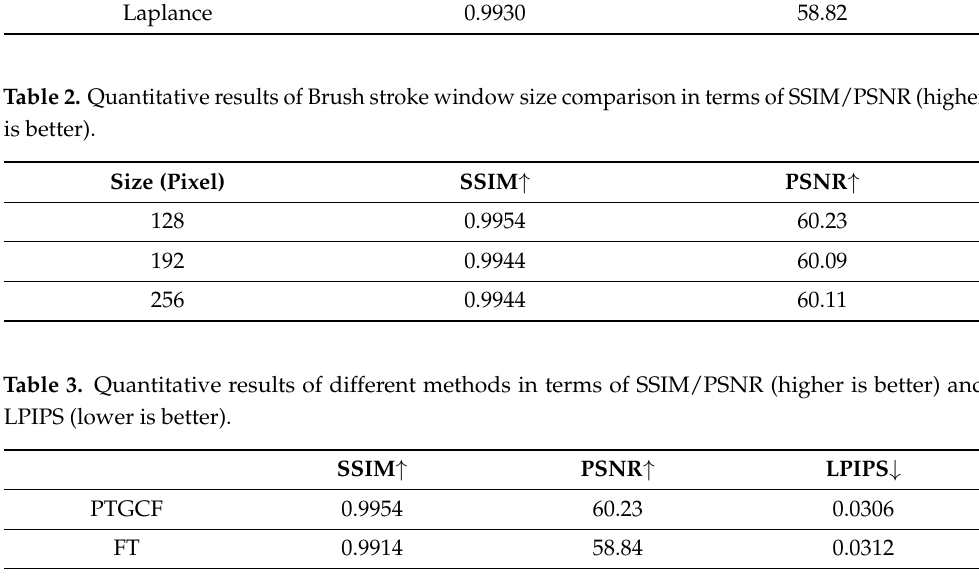
Table 1. Quantitative results of different edge enhancement methods in terms of SSIM/PSNR (higher is better).